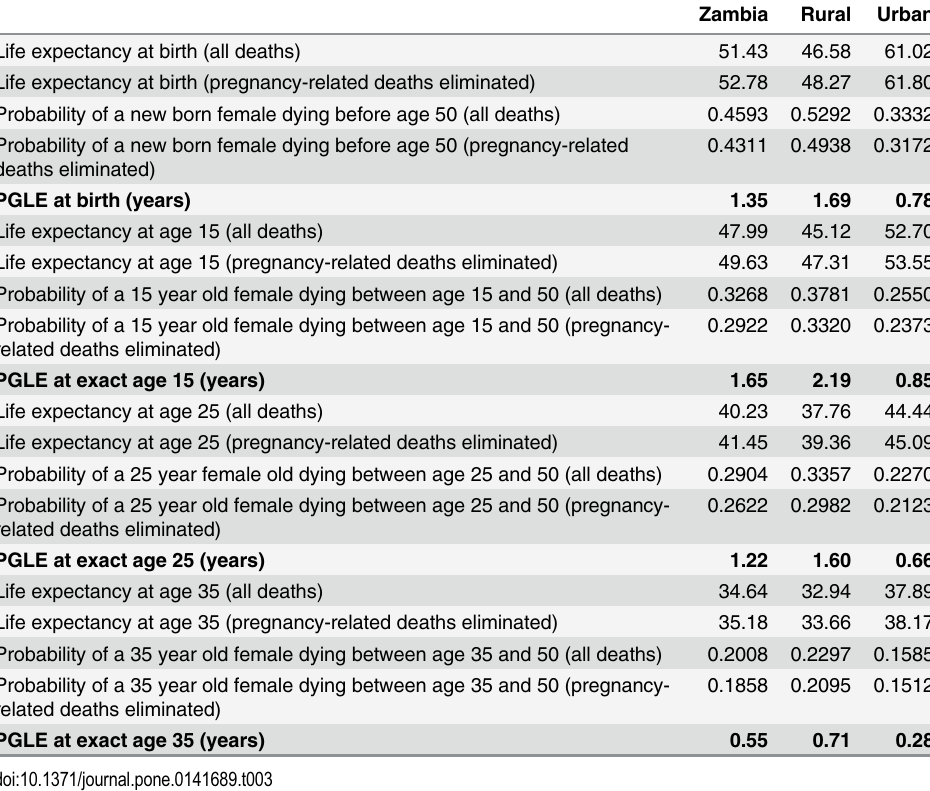
Table 3. Life expectancy and probability of dying before age 50, at different ages, for all-cause mortal- ity and when pregnancy-related deaths are eliminated, and the potential gain in life expectancy (PGLE), females only, Zambia 2010, by rural-urban residence and